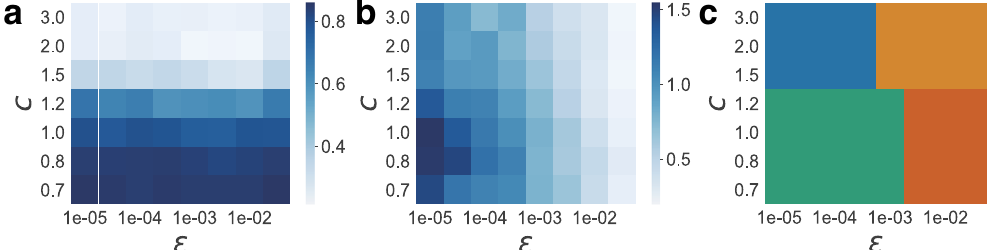
Fig. 3 Dependence of family strategy parameters on environmental parameter values. The graphs show the average values of family strategies ( a , the probability to form extended families s and b the inequality in inheritance λ ) in the last 1000 steps of simulation. c Phase diagram of family systems. The environmental dependencies of stem (green), community (orange), absolute nuclear (blue), and egalitarian nuclear (yellow) families are shown. Parent – child relationship for residence is classi fi ed as that of an extended family if s ≥ 0.5 and as that of a nuclear family if s < 0.5. Inter-sibling relationship for inheritance is classi fi ed as unequal if λ (cid:5) log2 and as equal if λ <